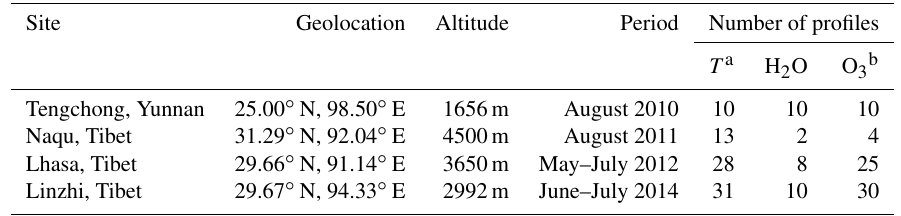
Table 1. Radiosonde site information for data used in this validation. The rightmost column lists the number of profiles for which a collocated Aura MLS profile was identified (see Sect.